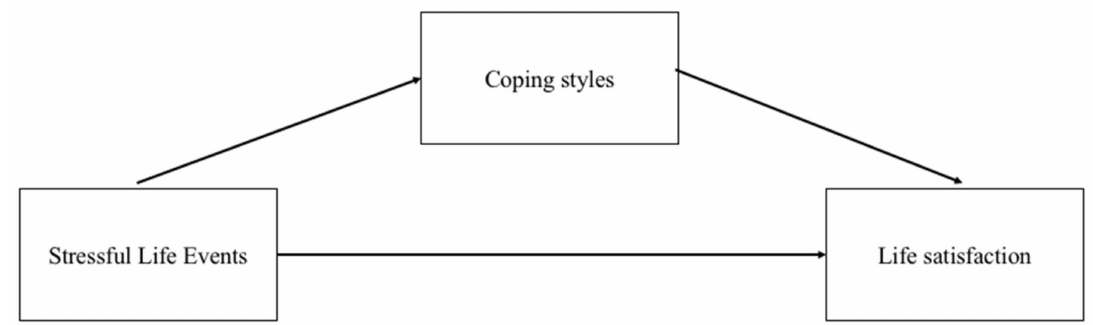
Figure 1. Illustration of the theoretical framework. Note. For simplicity of presentation, control variables are not shown.